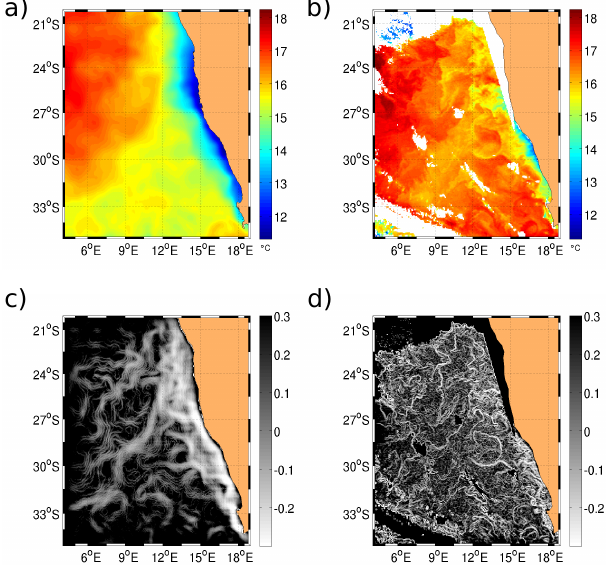
Figure 3. Snapshot of SST fields corresponding to 21 Septem- ber 2006 regridded at 1 / 32 ◦ of spatial resolution from OSTIA (a) and MODIS (b) . (c) and (d) are the spatial distribution of singularity exponents of the SST plotted in (a) and (b) ,